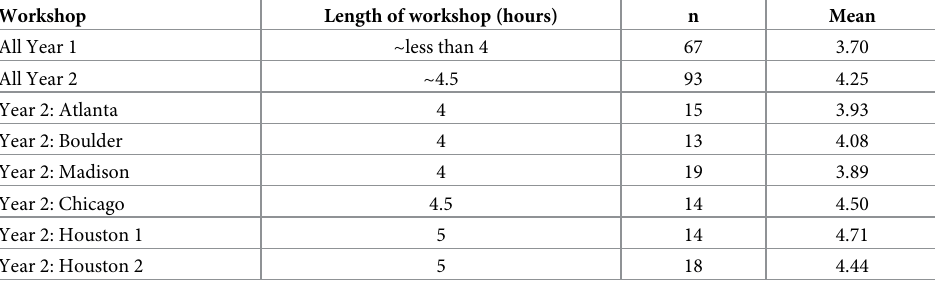
Average rating on a scale of 1 = strongly disagree to 5 = strongly